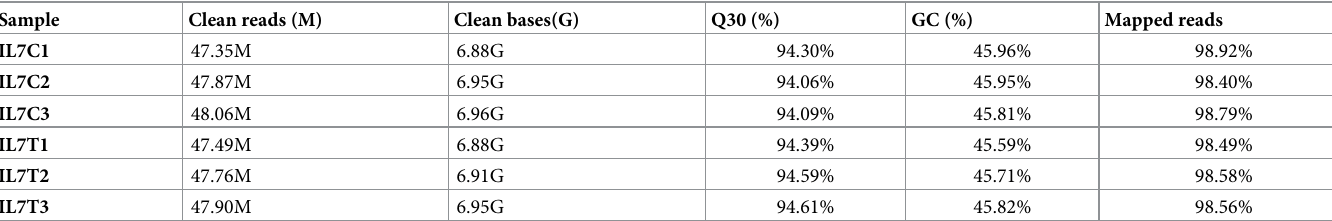
Table 1. Summary of sequencing data of IL7.